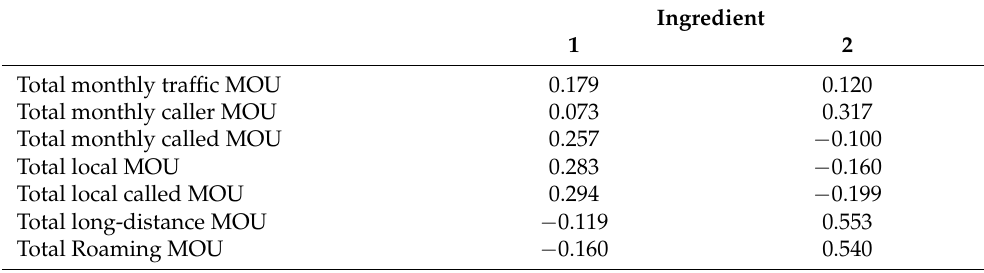
Table 12. Component score coefficient matrix.